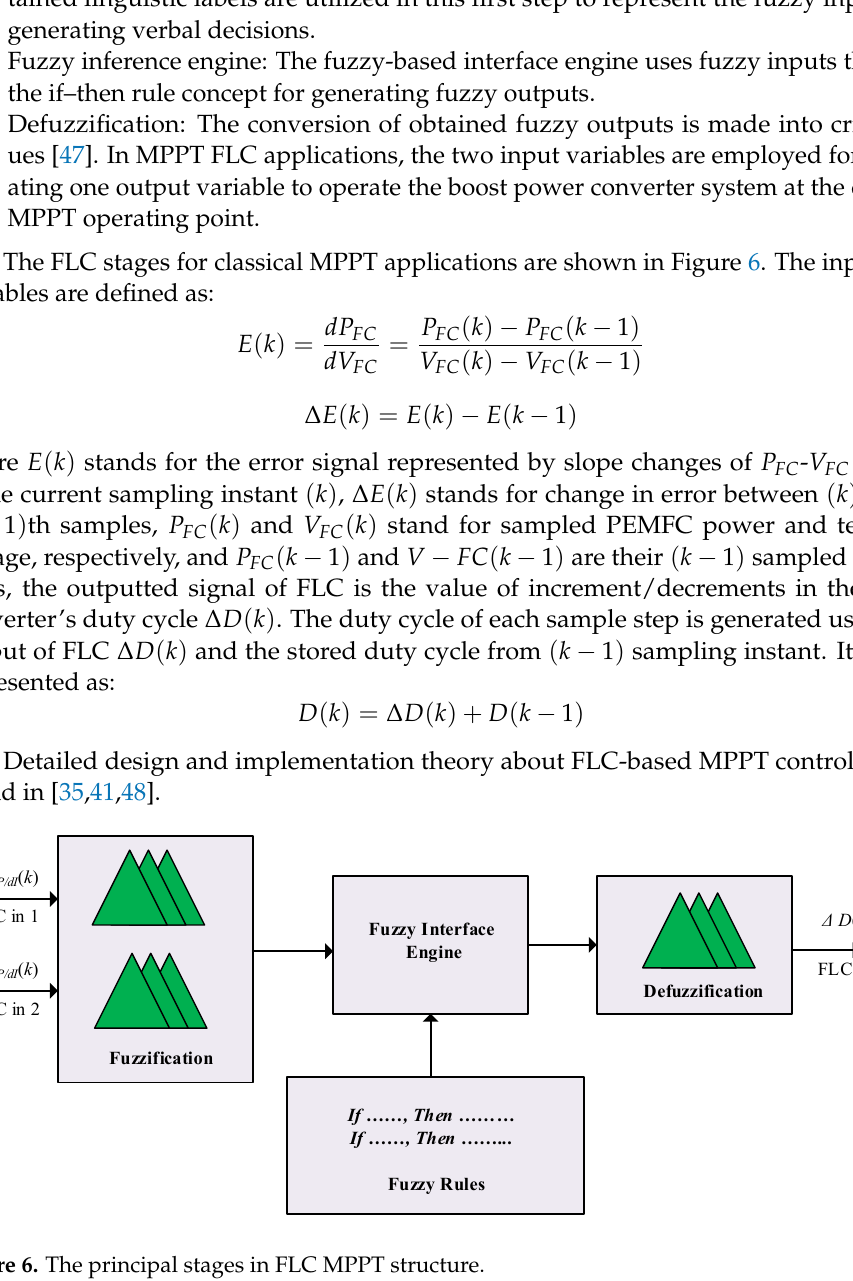
Figure 6. The principal stages in FLC MPPT